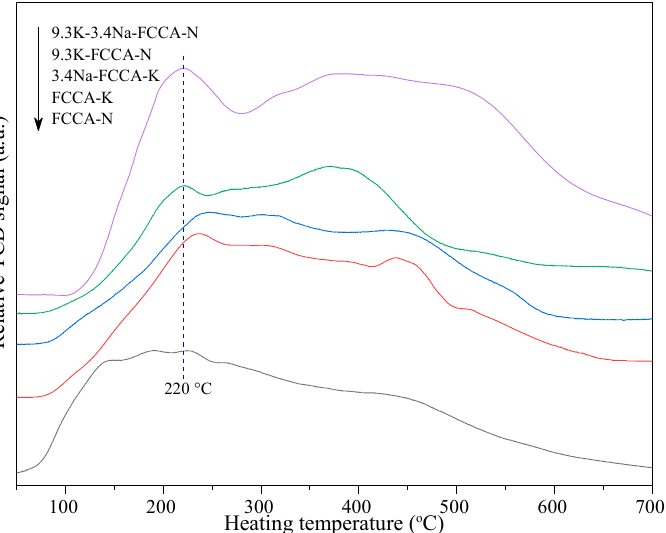
Figure 3. H 2 -TPD curves of reduced FeCoCuAl catalysts before and after K and/or Na modification. Catalyst reduction at 400 °C for 1 h in pure H 2 .